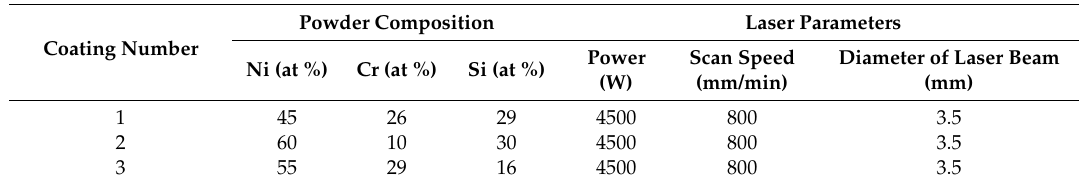
Table 1. Compositions of Ni-Cr-Si powders and laser